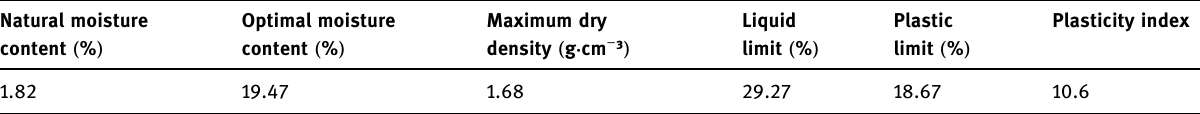
Table 2: Basic physical property indexes of yellow mud Natural moisture